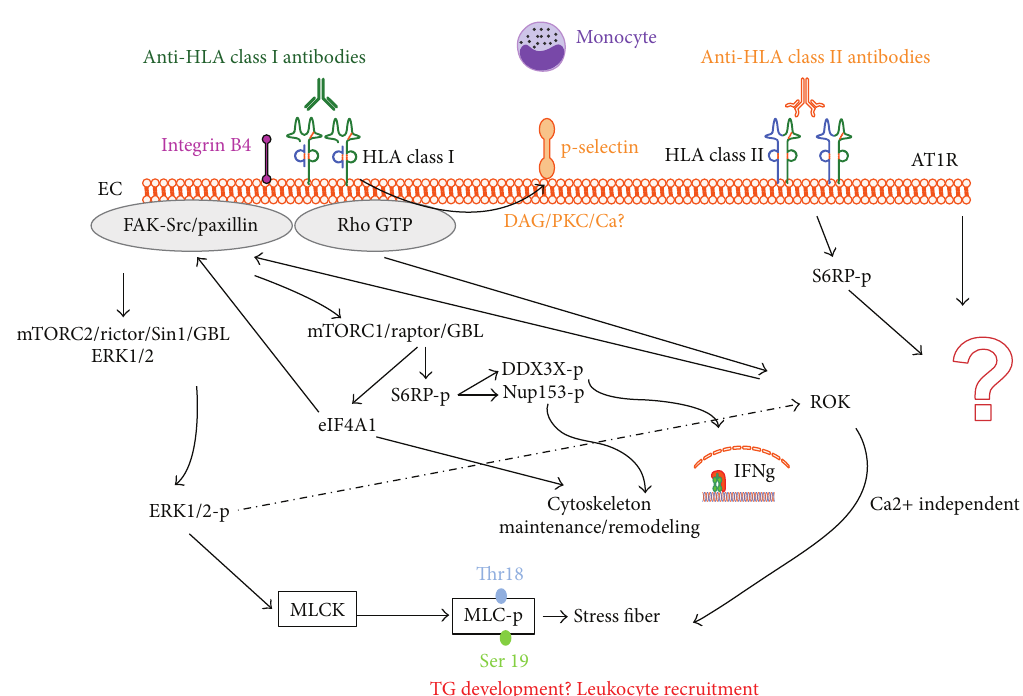
Figure 3: Intracellular signalling pathways mediated by HLA class I or II antibody binding to endothelial cells. The observation that the main HLA class I antibody binding stimulates intracellular EC pathways via the integrin 𝛽 4 subunit is summarized in this figure. After stimulation cytoskeleton remodelling and stress fiber formation via ERK pathway occur with calcium dependent and independent signalling leading to possible TG development and inflammatory cell